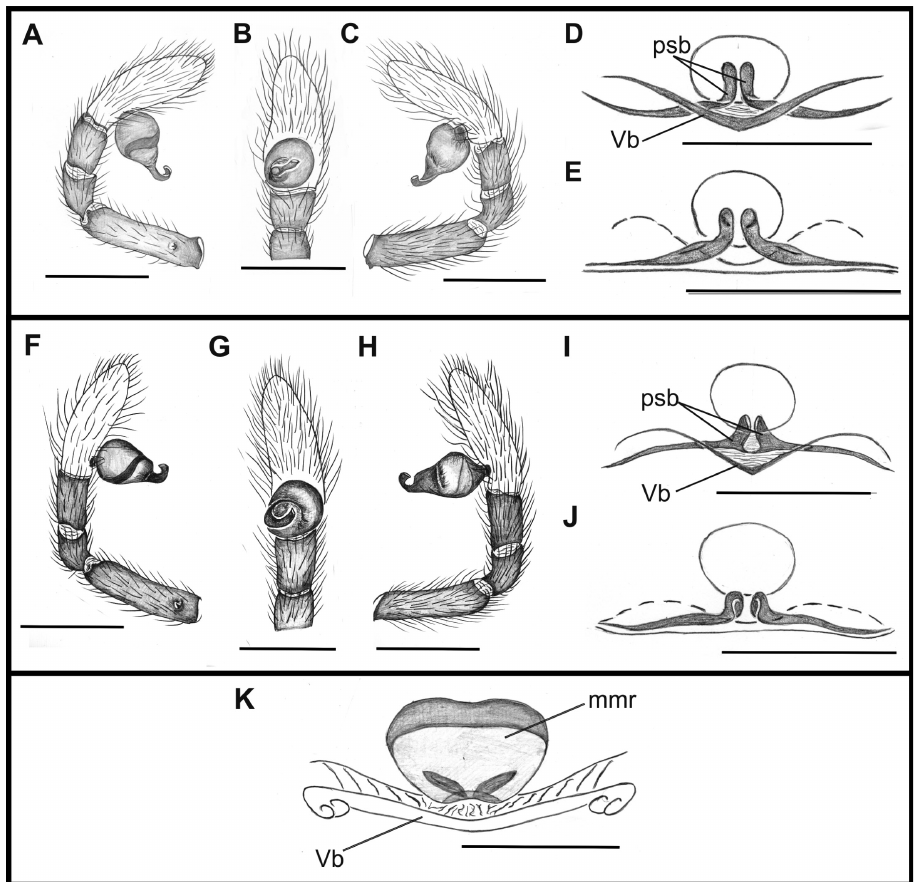
Figure 4. Tisentnops mineiro sp. n. , male from Moeda, Minas Gerais ( A–C ), female from Santa Bárbara, Minas Gerais (IBSP 191313) ( D–E ), Tisentnops onix sp. n. , male holotype (F–H), female paratype ( I–J ). Taintnops paposo sp. n. from Taltal, Antofagasta, Chile ( K ). A left pedipalp, prolateral view B same, ventral view C same, retrolateral view D sclerotized parts of internal genitalia, ventral view E same, dorsal view F left pedipalp, prolateral view G same, ventral view H same, retrolateral view I sclerotized parts of internal genitalia, ventral view J same, dorsal view K internal genitalia, ventral view (mmr = membranous anteromedian receptaculum; psb = pair of sclerotized bars; Vb = V-shaped bar). Scale